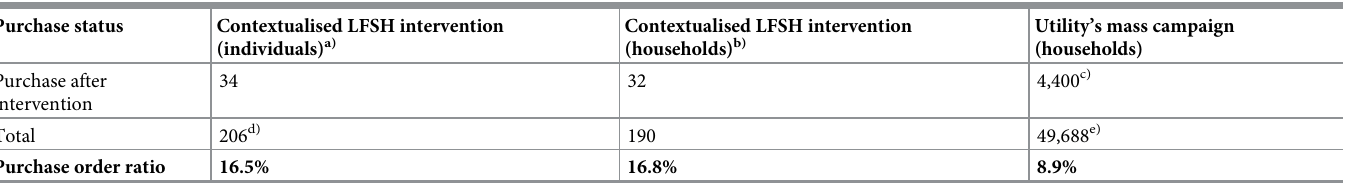
Table 2. Purchase status of participants living in Winterthur.